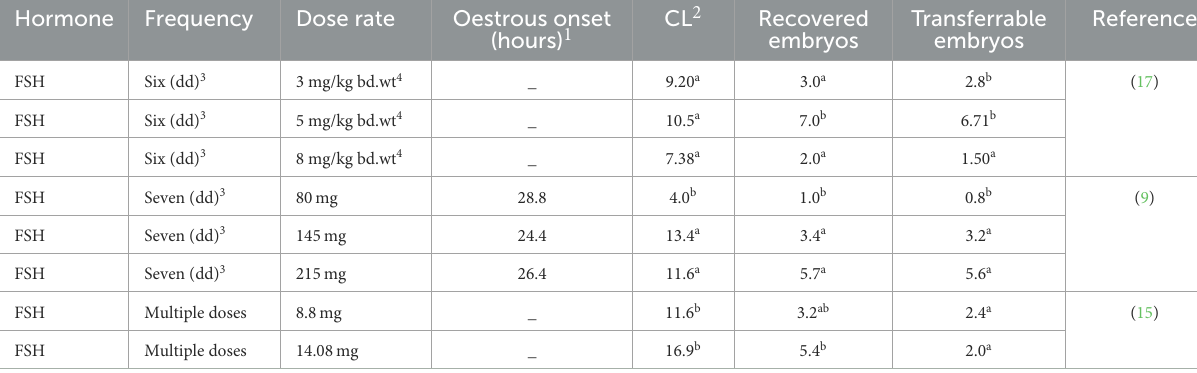
TABLE 2 Effect of different hormone doses on the superovulatory